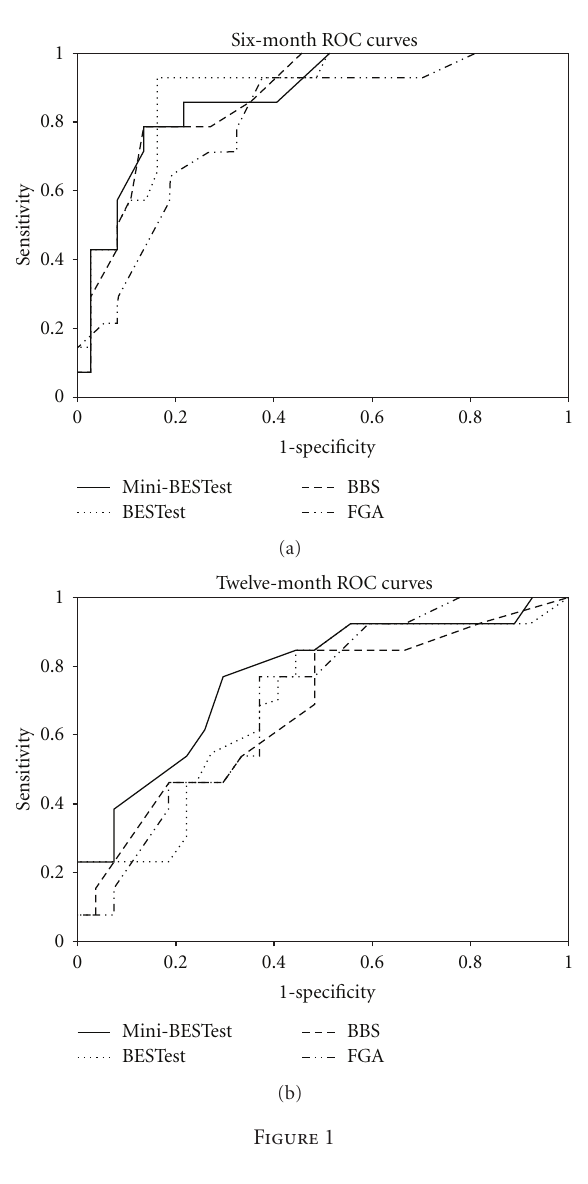
Table 3: P Values for 6 month NonInferiority test of